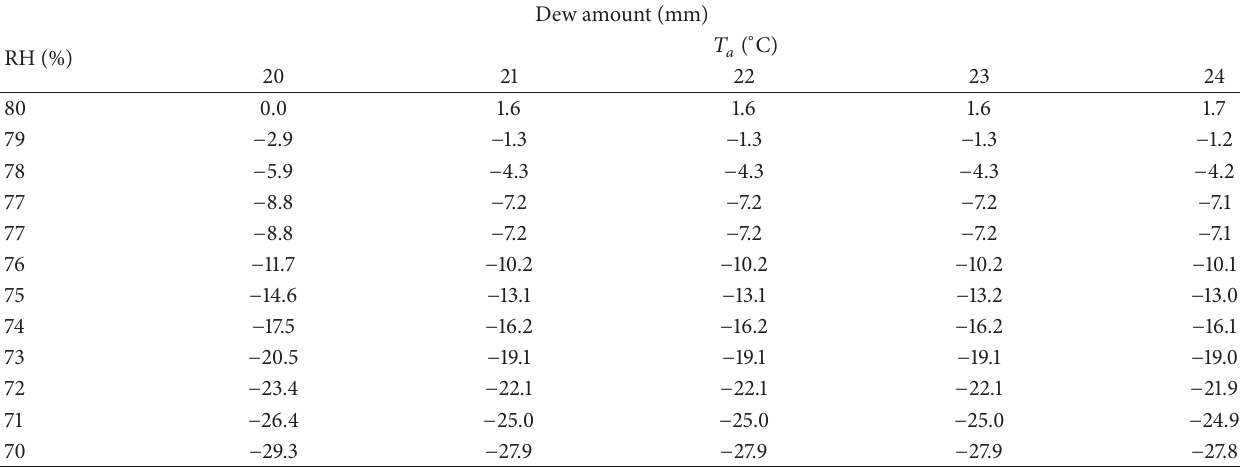
Table 6: The average decrement of dew amount due to climate changes.